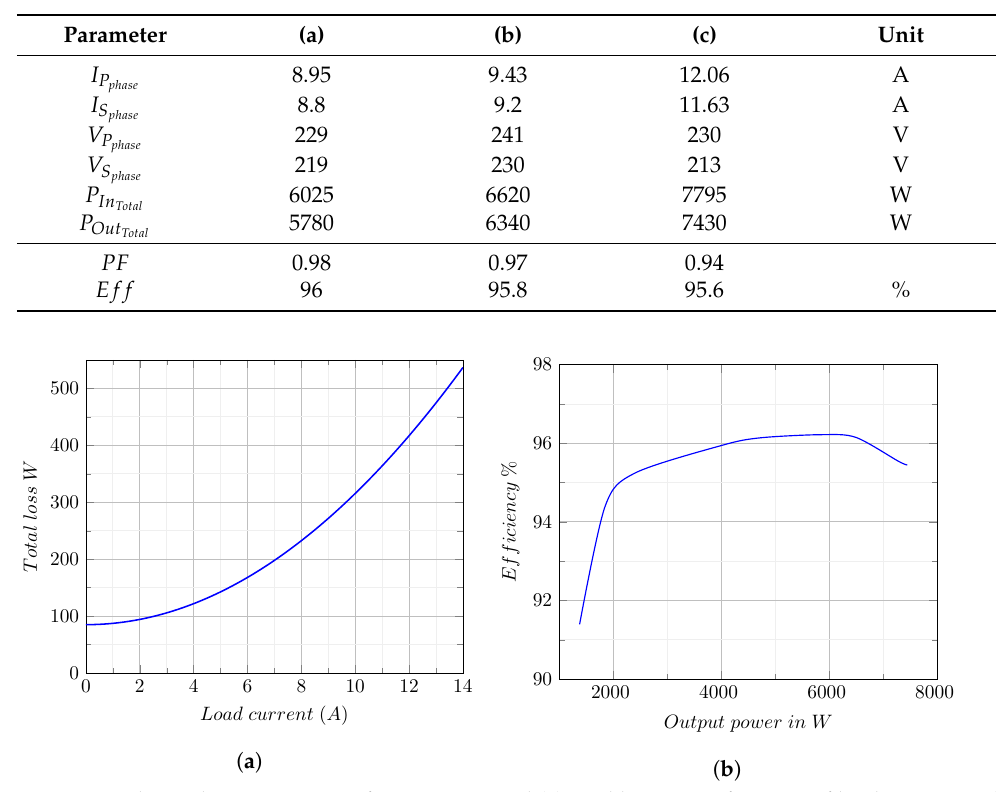
Figure 13. Three-phase rotary transformer measured ( a ) total losses as a function of load current and ( b ) efficiency as a function of output power, both at 400 V L–L input voltage.